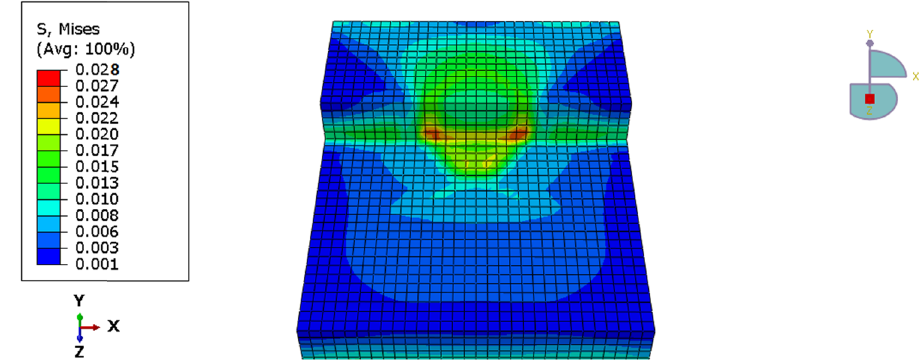
Figure 23: Stress distribution on soil behind thrust block ( MPa ) .